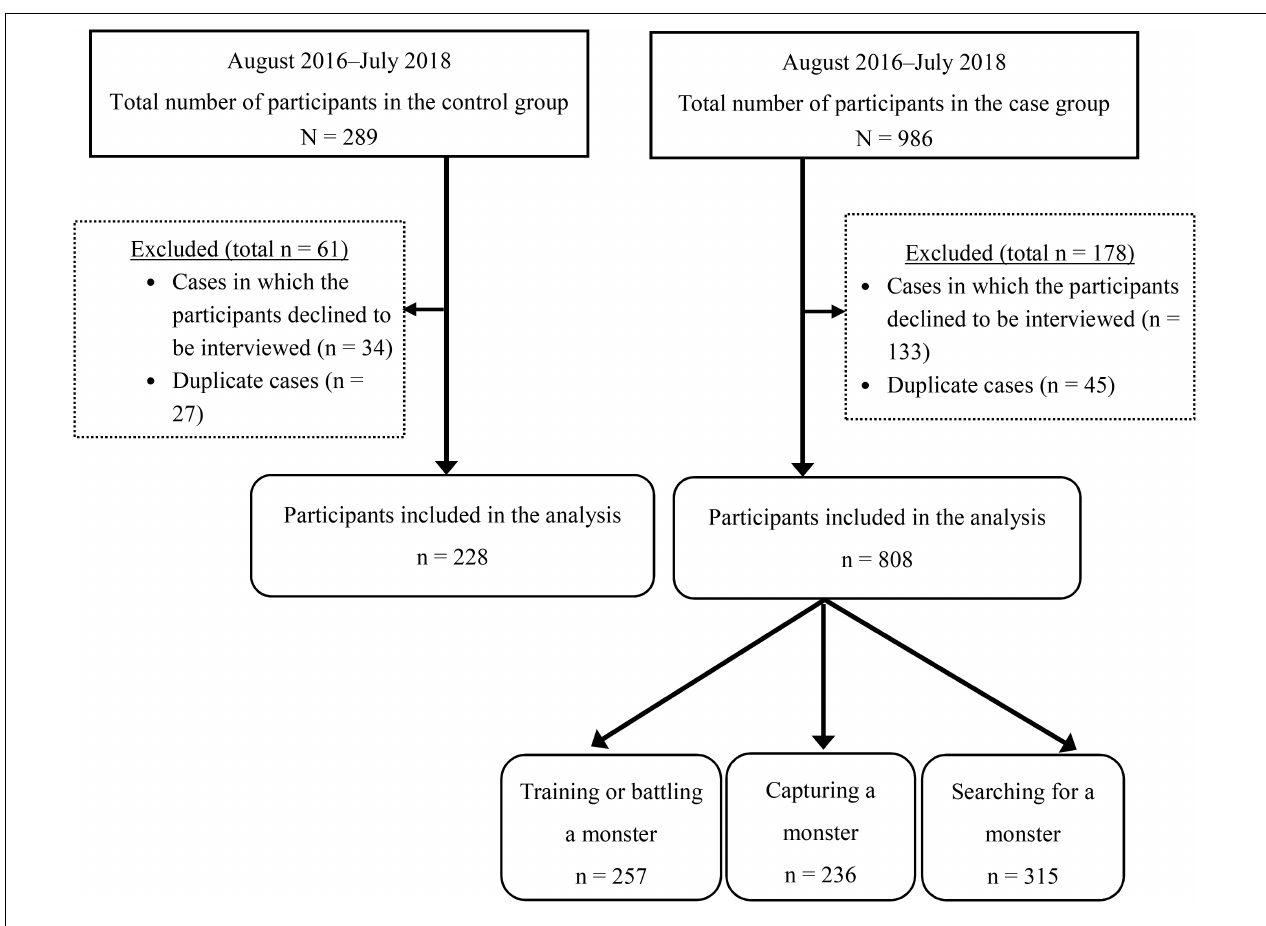
FIGURE 2 | Study flow chart.